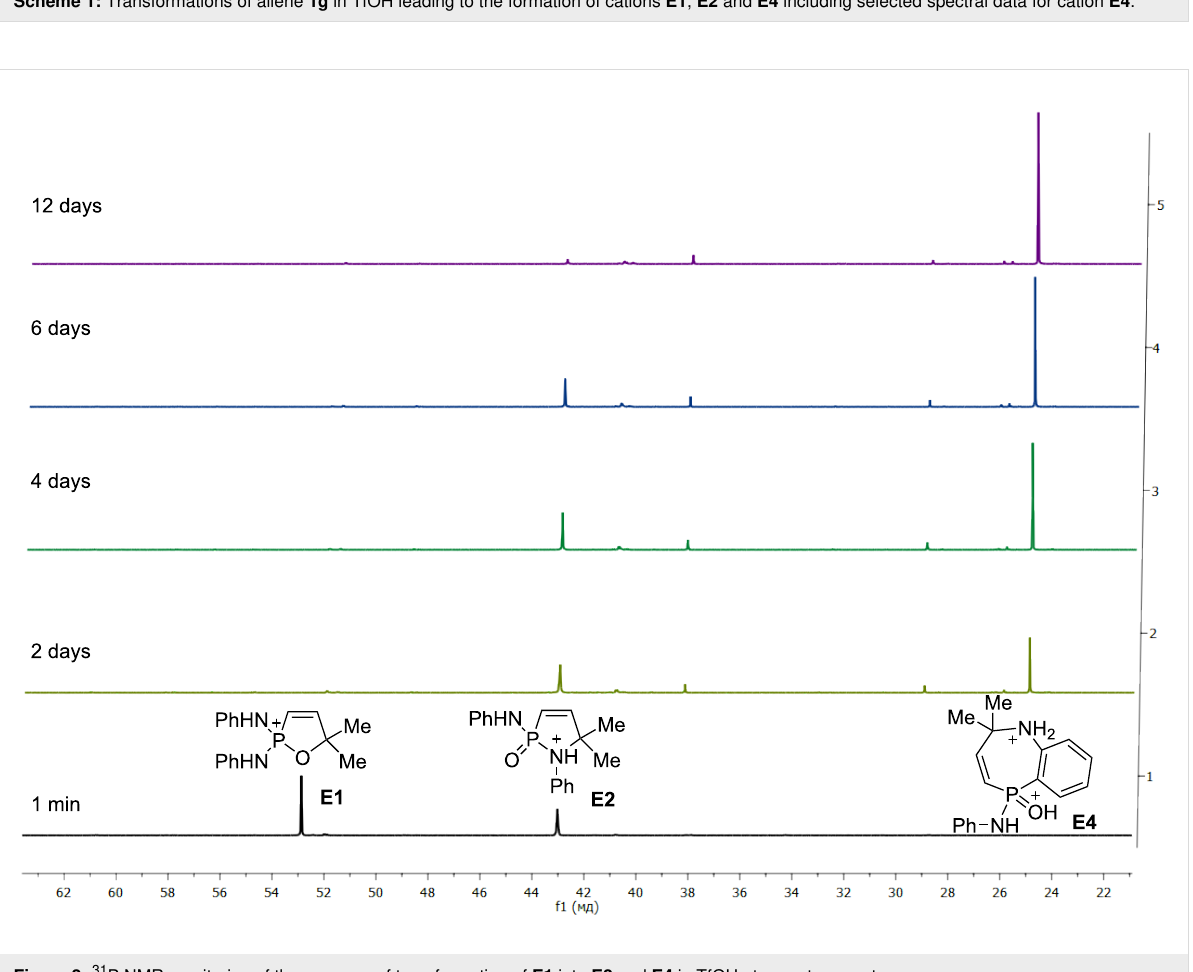
analysis (see Supporting Information File 1). On the other